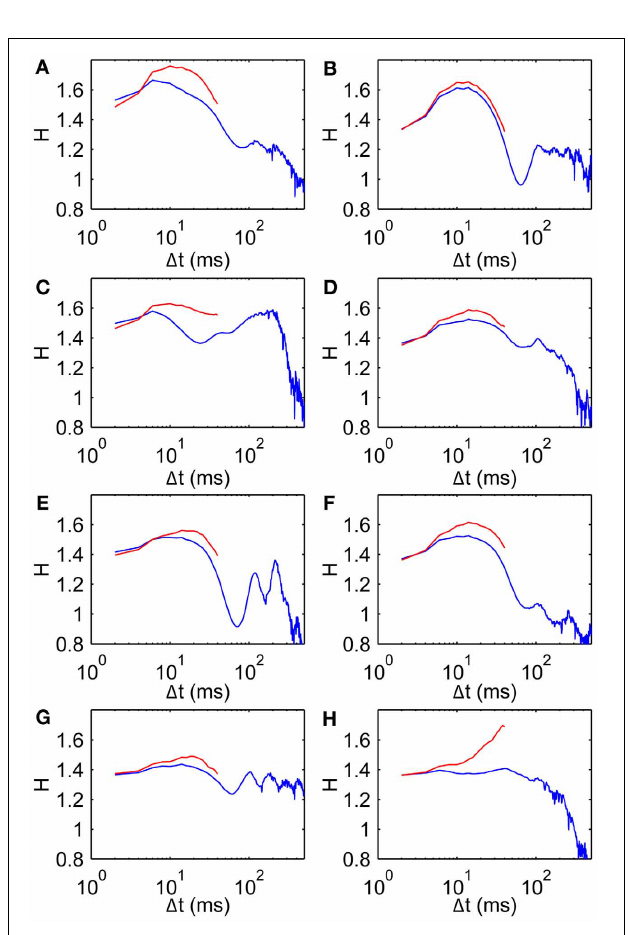
FIGURE 4 | Scaling exponents for all subjects when restricted to middle 50ms of each fixation. (A–H) Subjects 1–8, respectively, showing scaling exponent H data (blue, same as Figure 3A ) and for the middle 50ms of each fixation (red). small biases in the directions parallel ( (cid:2) θ = 0) and antiparal- lel ( (cid:2) θ = ± π ) to the neighboring saccades. Drifts are slightly biased against the previous saccade direction, consistent with the